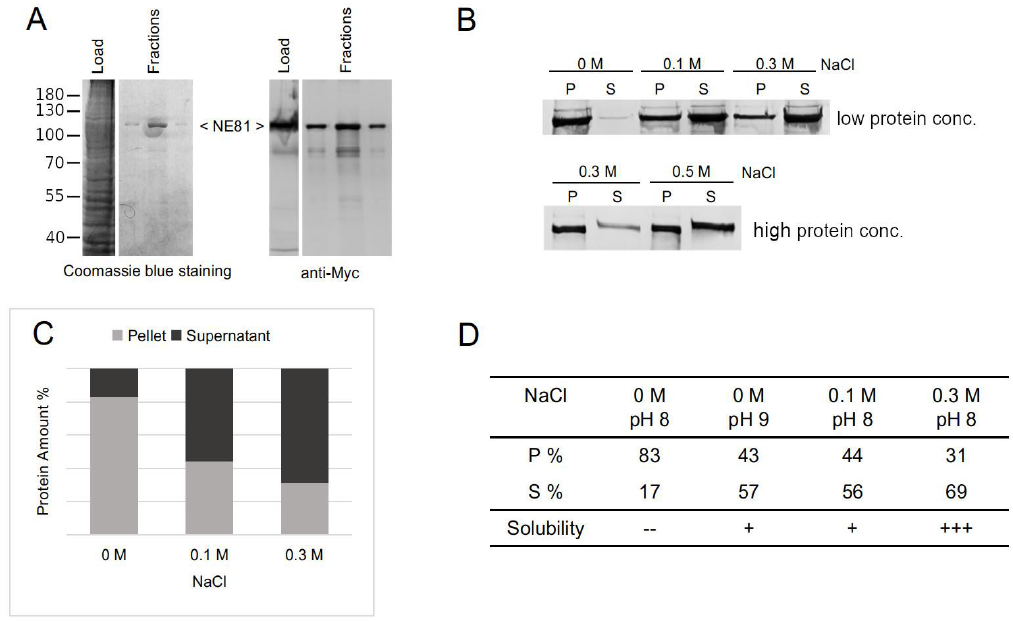
Figure 5. Formation of HisMyc-NE81 ∆ NLS ∆ CLIM assemblies is salt-dependent in vitro. ( A ) Affinity purification of HisMyc-NE81 ∆ NLS ∆ CLIM expressed in Dictyostelium at high-salt conditions (0.5 M NaCl). Proteins were separated on an 8% SDS-PAGE. A Coomassie blue staining (left) and a Western blot stained with anti-Myc/alkaline phosphatase and NBT/BCIP color detection of the total extract and Ni-NTA-chromatography fractions are shown. Molecular masses of standard proteins are indicated on the left. ( B ) Soluble purified HisMyc-NE81 ∆ NLS ∆ CLIM at two starting concentrations (low concentration = 0.2 mg/mL; high concentration = 0.4 mg/mL) was dialyzed against 25 mM Tris-HCl pH = 8.0 and indicated NaCl concentrations, followed by centrifugation. Equivalent amounts of pellet (P) and supernatant (S) were loaded on SDS gels, blotted, stained with anti-myc antibodies, and detected as described above. Low concentration: protein amount in the pellet decreases with increasing NaCl concentration. ( C ) Chart depicting densitometric percentages of HisMyc-NE81 ∆ NLS ∆ CLIM in supernatants and pellets obtained at the indicated salt conditions (low protein concentration = 0.2 mg/mL protein). ( D ) Percentages of HisMyc-NE81 ∆ NLS ∆ CLIM in supernatants and pellets obtained at the indicated salt and pH conditions (low protein concentration = 0.2 mg/mL protein). Key: +++ most protein in supernatant, + around half of protein in supernatant, - - most of protein in pellet.